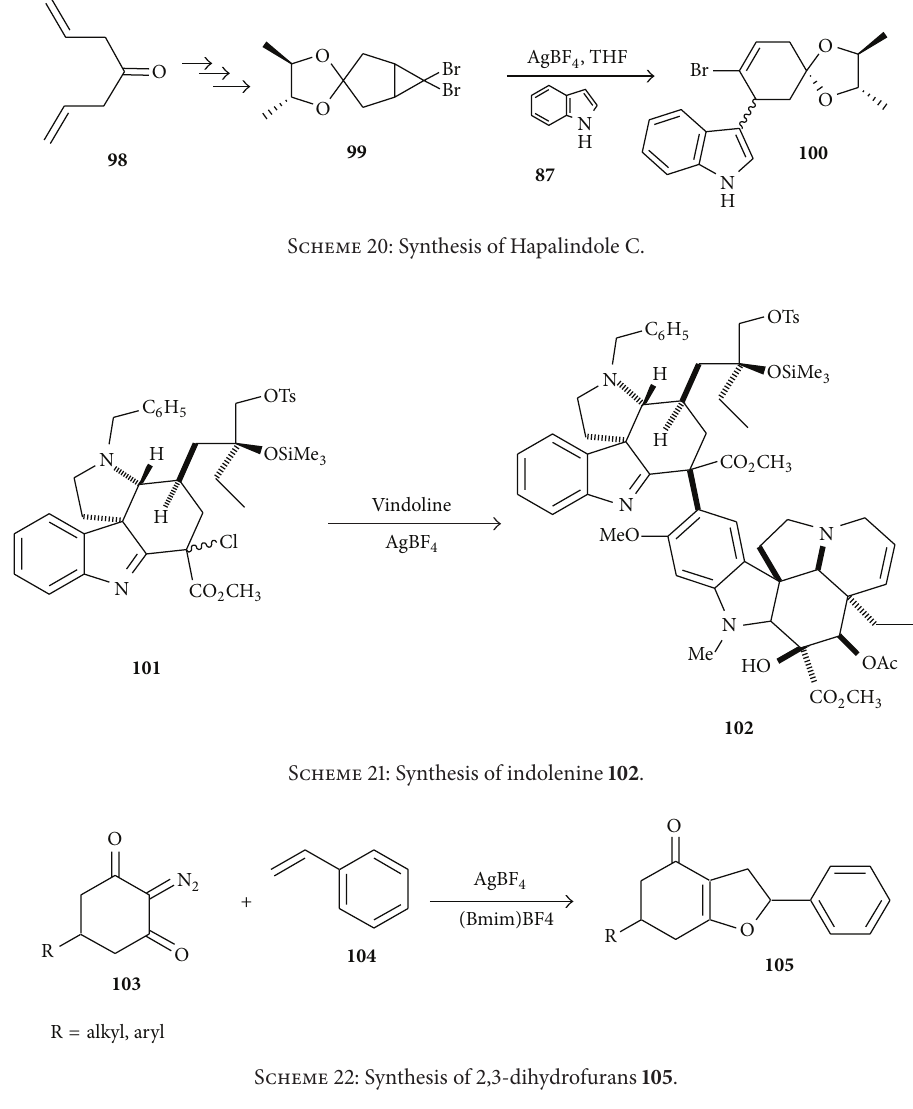
Scheme 22: Synthesis of 2,3-dihydrofurans 105